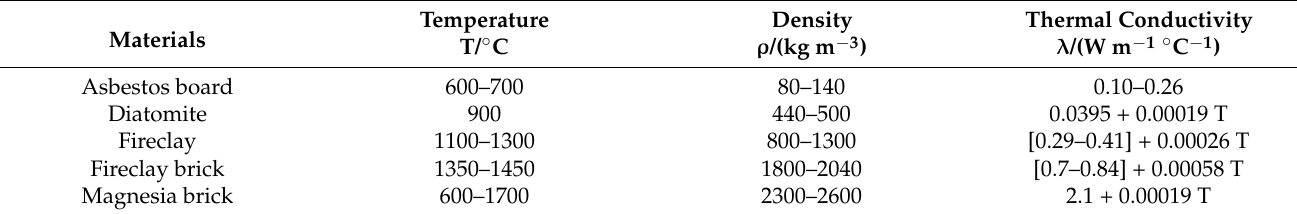
Table 3. Main parameters of the refractory materials.